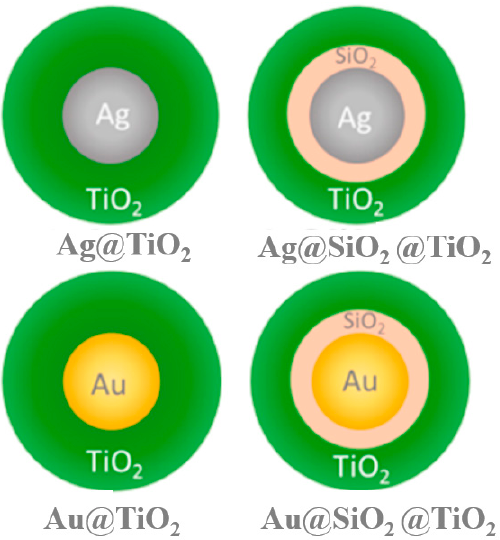
Figure 27. Schematic drawing of metal @ TiO 2 and Ag @ SiO 2 @ TiO 2 structure [104].